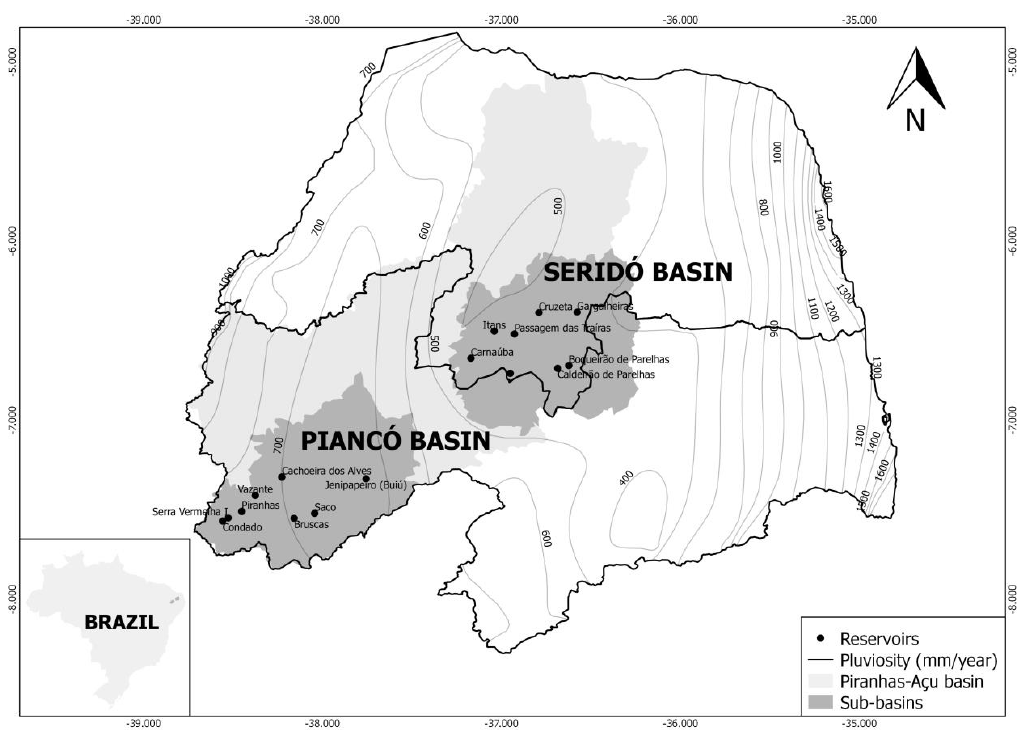
Figure 1. Map of Brazil highlighting the Piancó (PB) and Seridó (SB) basins inserted in the Piranhas-Açu River watershed. The lines connecting places that receive equal amounts of rainfall (isohyets), show the differences in mean annual rainfall (MAR) between the regions. Both sets of reservoirs are located in the semi-arid, but in the SB the MAR is around 500 mm/year, whereas in the PB the MAR is around 700